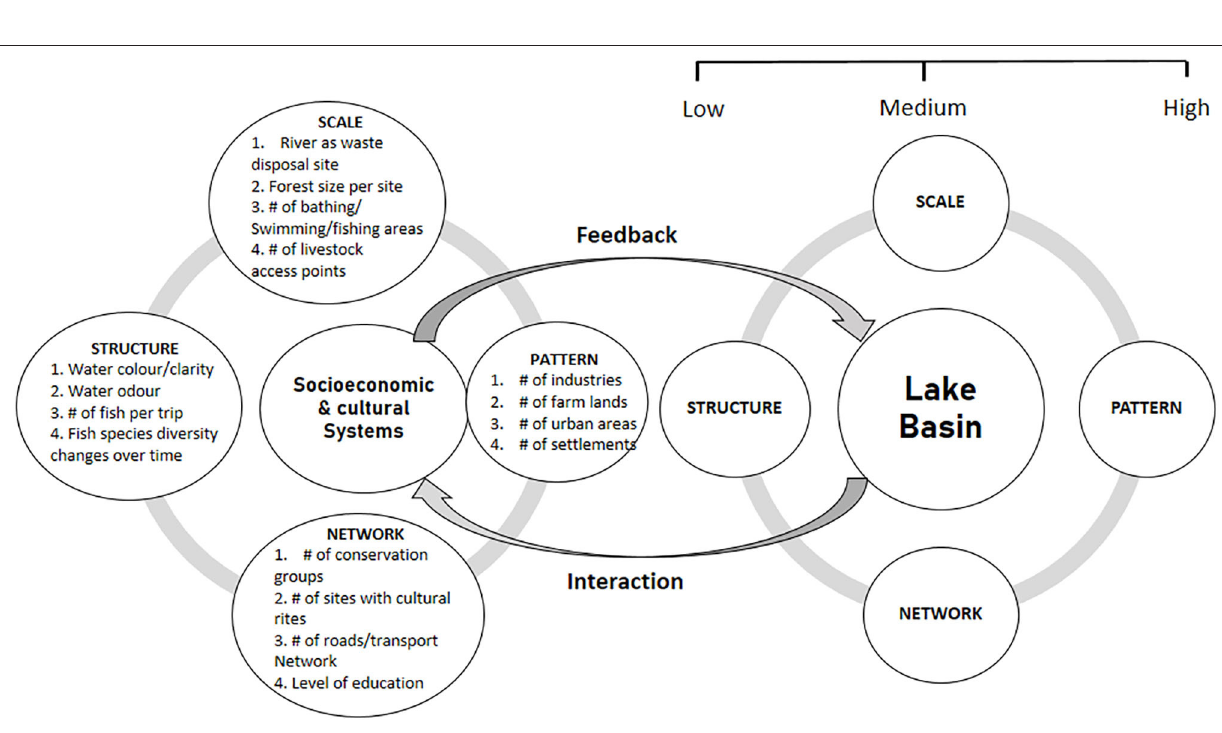
Frontiers in Water |